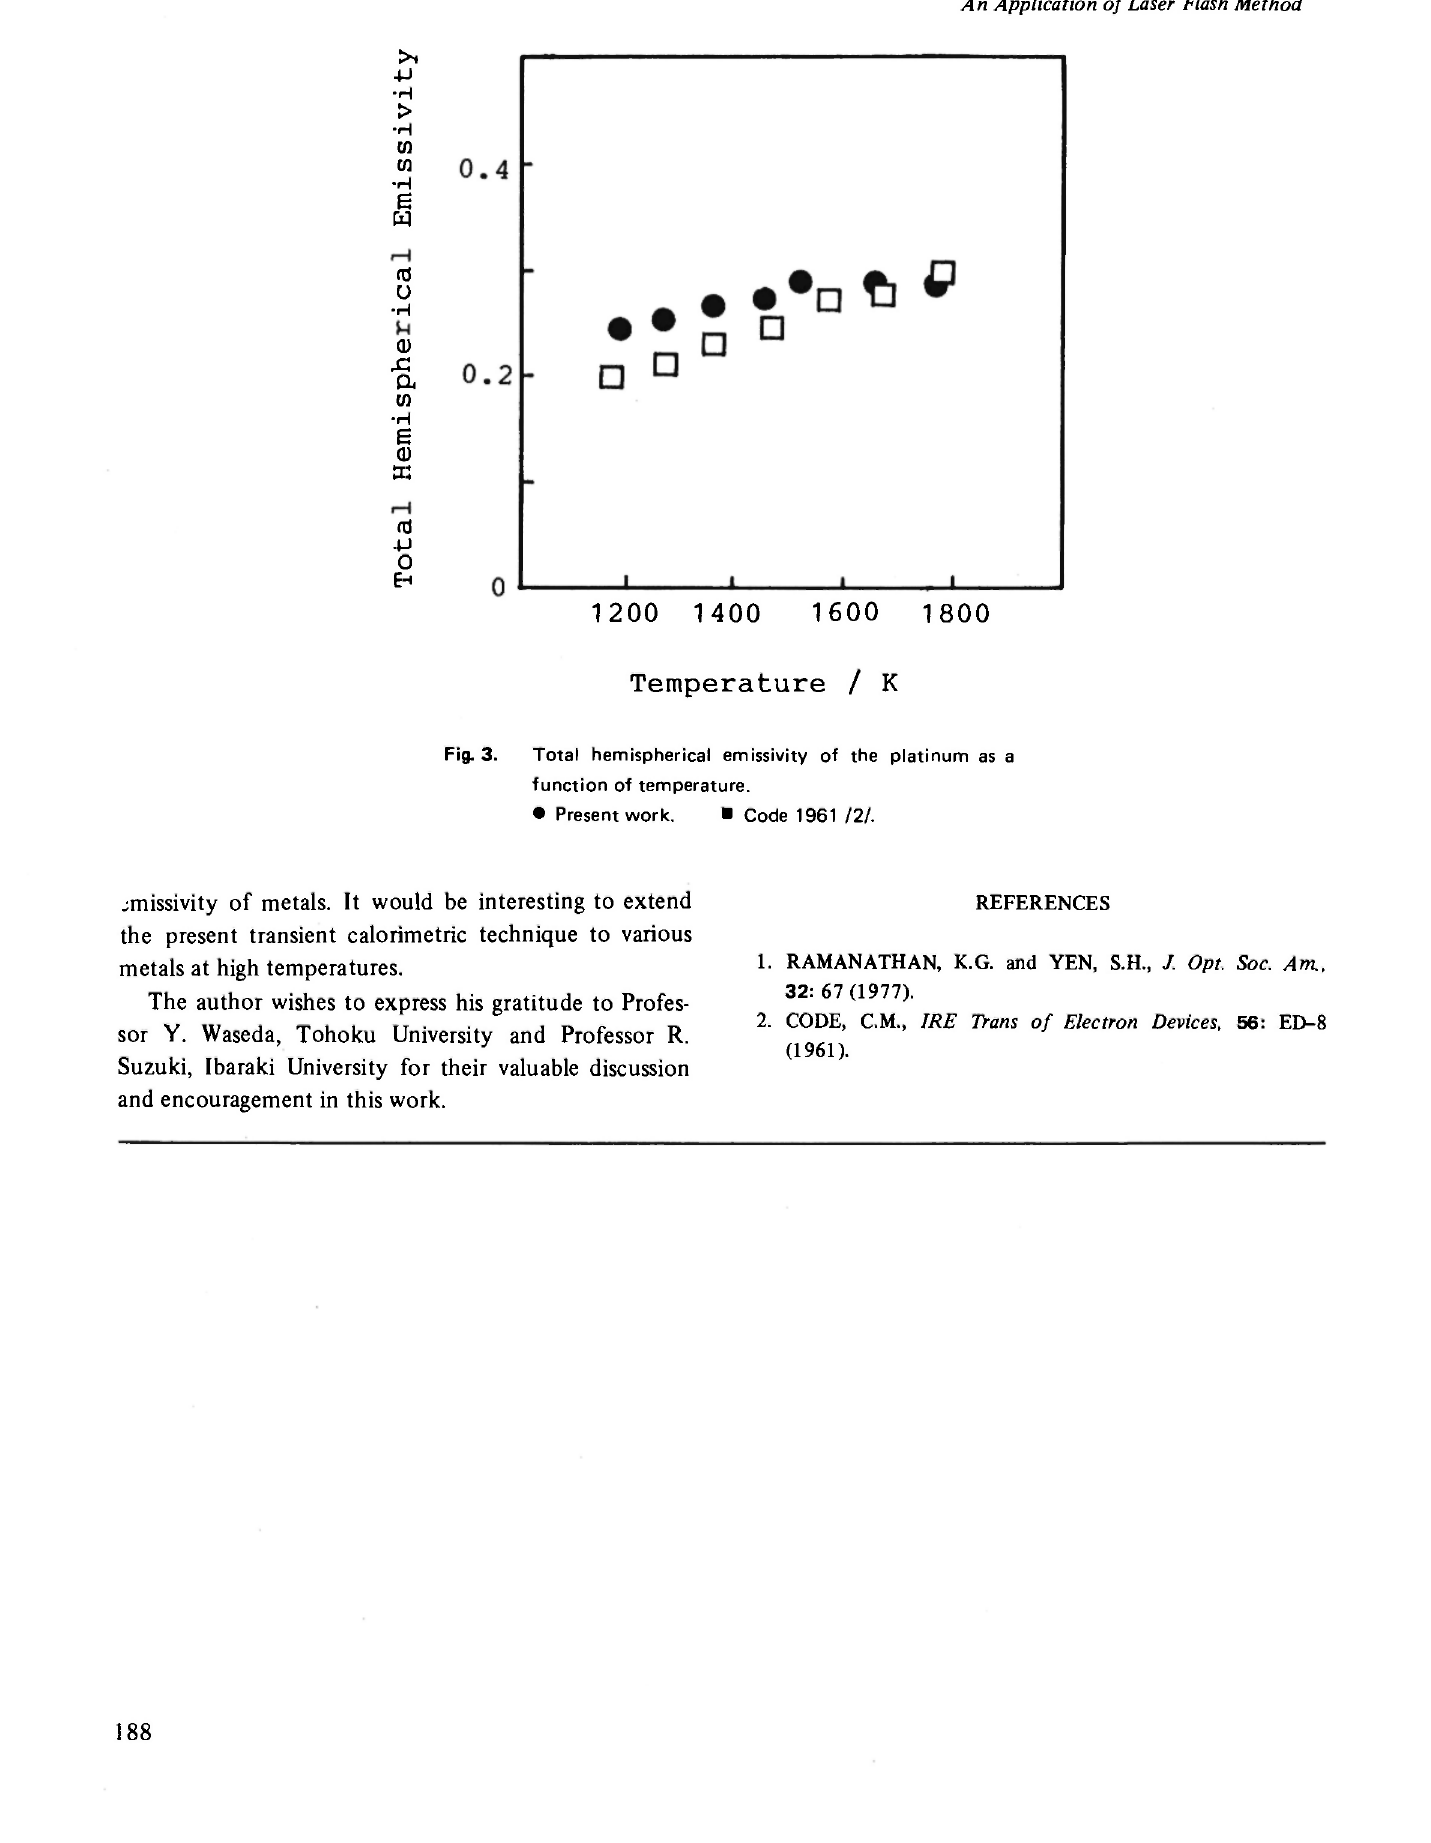
Fig. 3. Total hemispherical emissivity of the platinum as a function of temperature. • Present work. • Code 1961